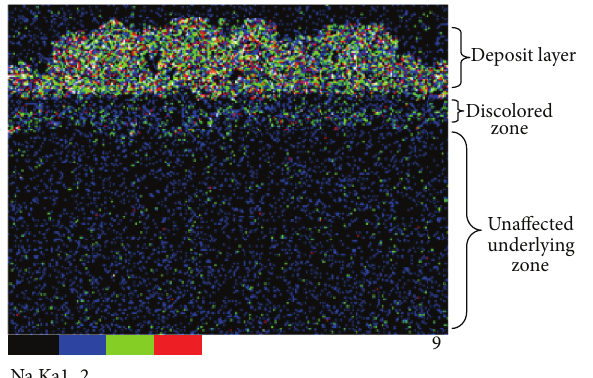
Figure 3: EDAX (Na element mapping) analysis of Fusion bond Epoxy coating exposed to 5% NaOH solution for 30 days at 93 ∘ C/200 ∘ F.